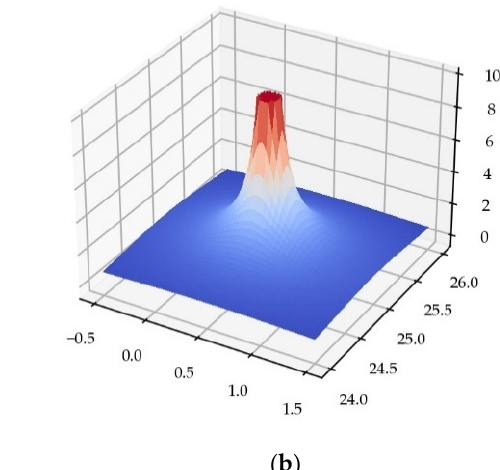
Figure 3. ( a ) Real component; ( b ) imaginary component; ( c ) absolute value of the 3D Diagrams of the three functions G , ζ , and F .